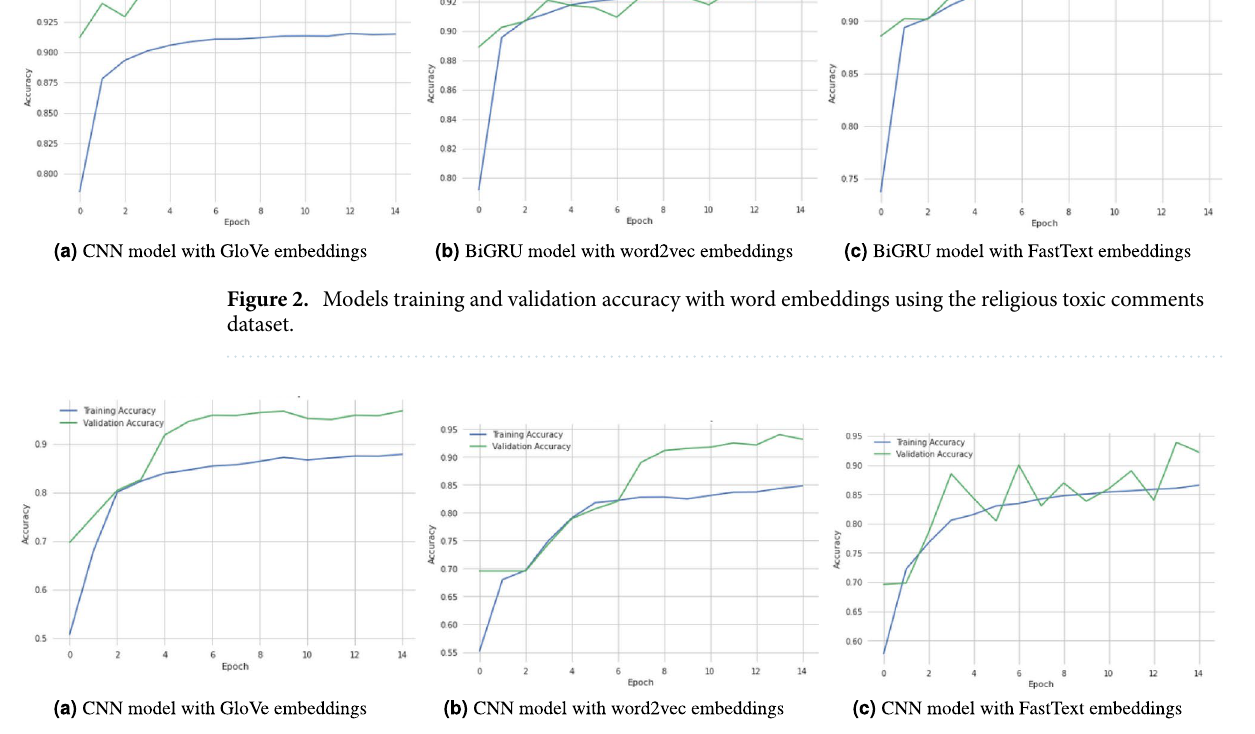
Figure 3. Models training and validation accuracy with word embeddings using the race or ethnicity toxic comments dataset.